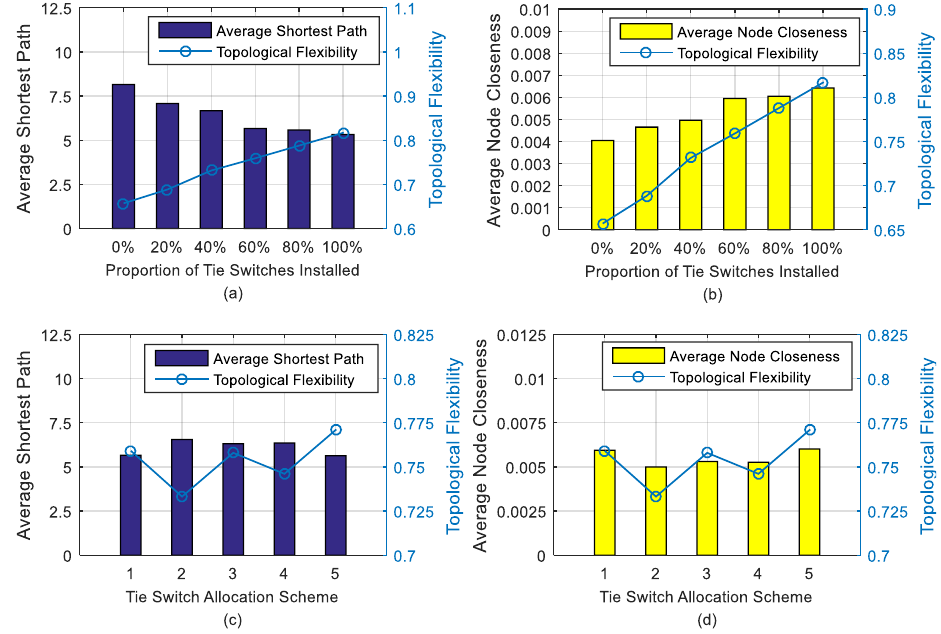
Figure 5. Distribution network topological flexibility, average shortest path, and average node closeness based on the change of tie switches. ( a ) Topological flexibility and average shortest path with the different number of tie switches; ( b ) topological flexibility and average node closeness with the different number of tie switches; ( c ) topological flexibility and average shortest path with different allocation schemes based on the same number of tie switches; ( d ) topological flexibility and average node closeness with different allocation schemes based on the same number of tie switches.